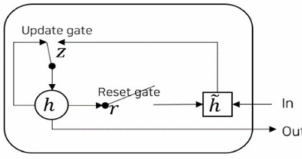
Figure 7. Structure of gated recurrent unit (GRU)